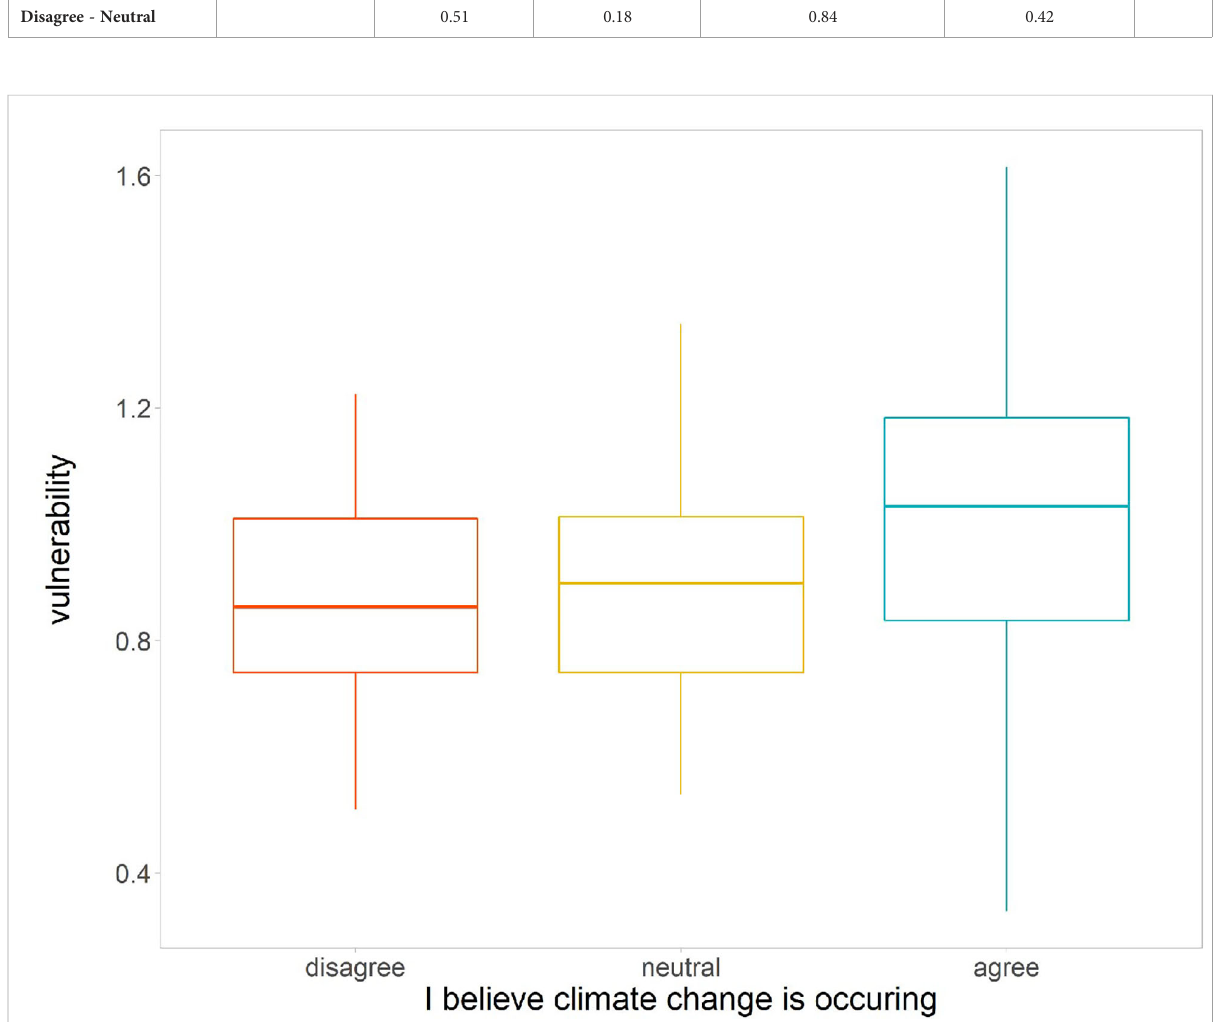
FIGURE 4 Distribution of perceived vulnerability scores based on whether respondents agreed (blue), were neutral (yellow) or disagreed (red) with the question “ I believe climate change is occurring ” .